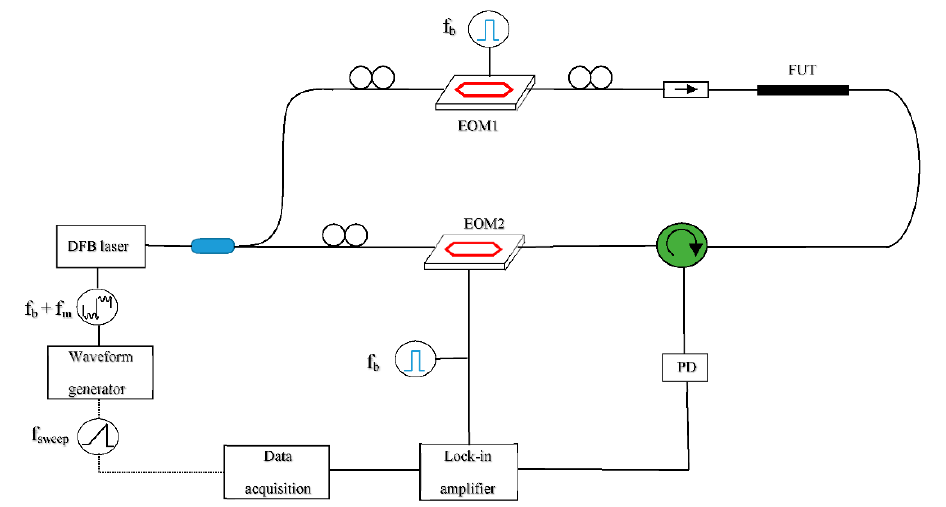
Figure 3. Experimental setup employed for BOCDA measurements; EOM, electro-optic modulator; PD, photodiode; FUT, fiber under test (Adapted from Ref. [39]).